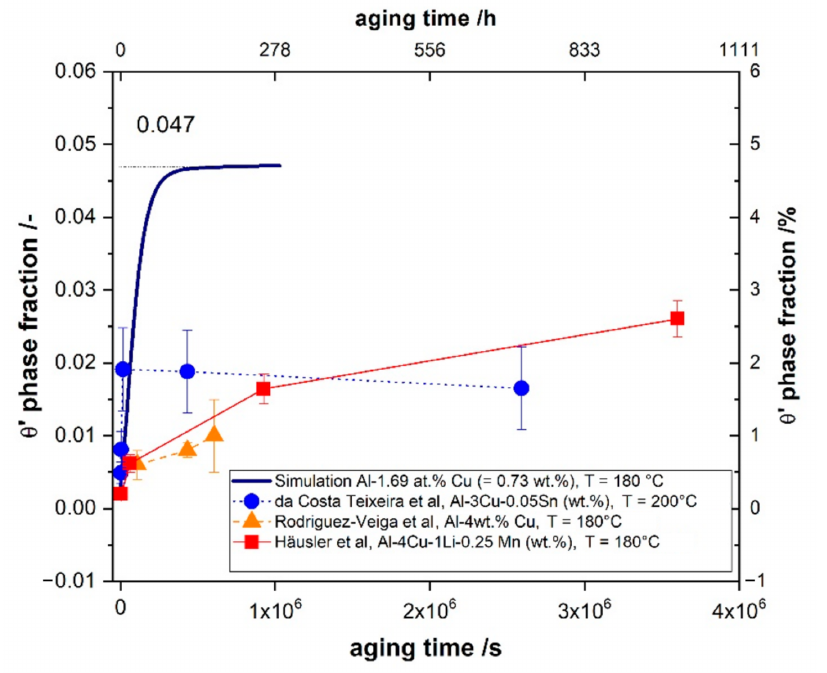
Figure 15. Temporal evolution of the volume fraction of the θ (cid:48) phase for 82 precipitates simulation (continuous blue line) in Al-1.69 at.% Cu alloy annealed at 453 K for 480,000 s (cf. Figure 14b) compared with experimental data (da Costa Teixeira et al., Ref [17], Häusler et al., Ref [58], Rodr í guez- Veiga et al., Ref